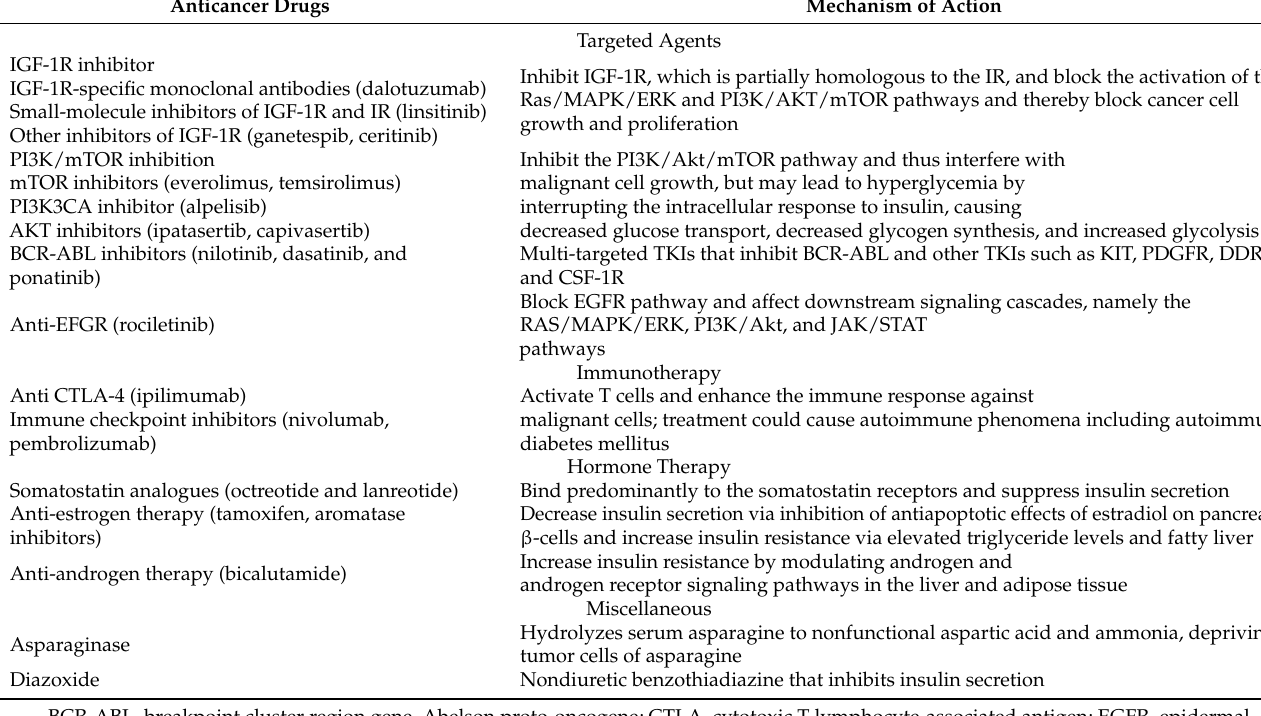
Table 1. Cancer drugs and their mechanism causing